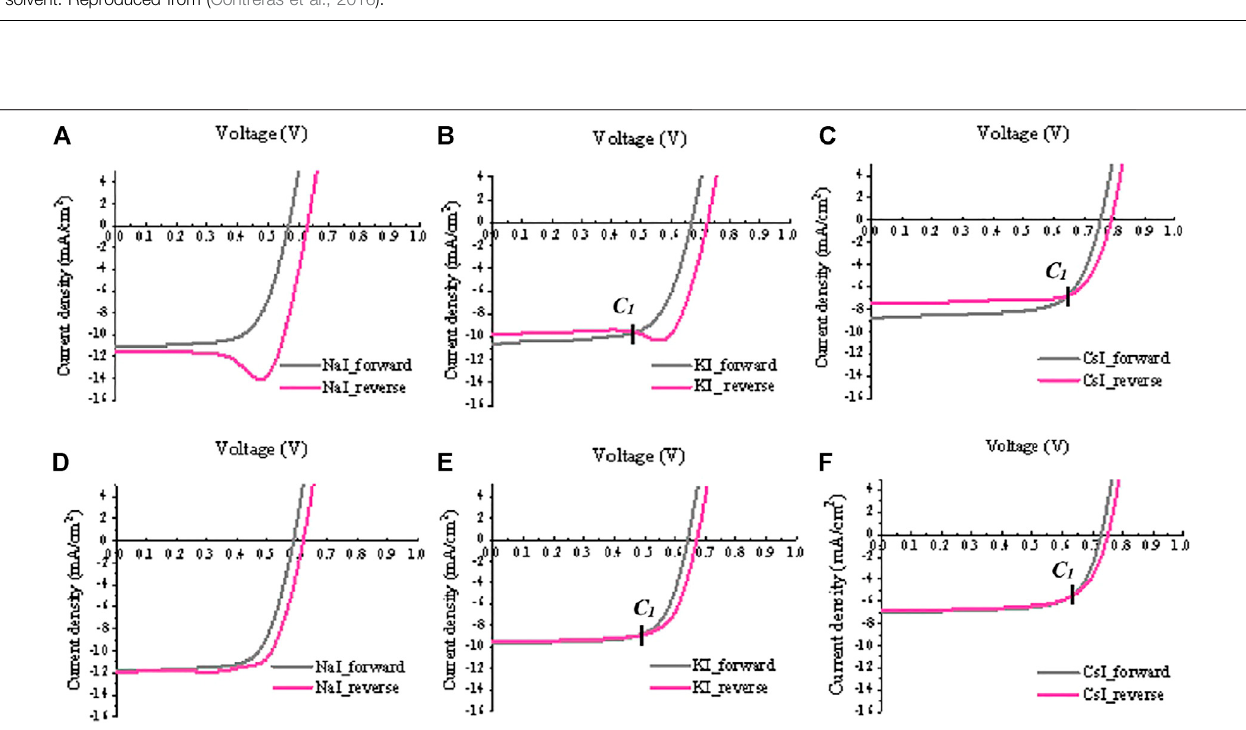
FIGURE3| Theforwardandreversecurrent – voltagecharacteristicsforDSCsfabricatedwithanelectrolytecontaining (A) NaIat1V/sscanrate, (B) KIat1V/sscan rate, (C) CsI at 1V/s scan rate, (D) NaI at 0.5V/s scan rate, (E) KI at 0.5V/s scan rate, (F) CsI at 0.5V/s scan rate. Reproduced with permission from (Elbohy et al., 2019).